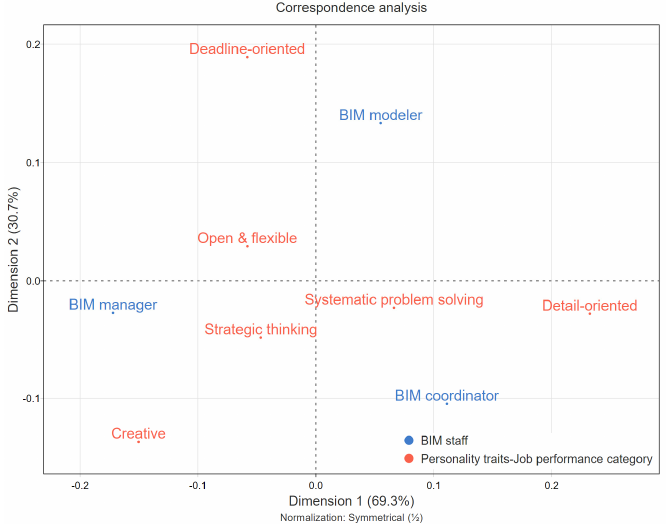
Figure 7. Comparison of the required degree of personality traits (job performance category), be ‐ tween BIM staff roles, in a correspondence analysis.